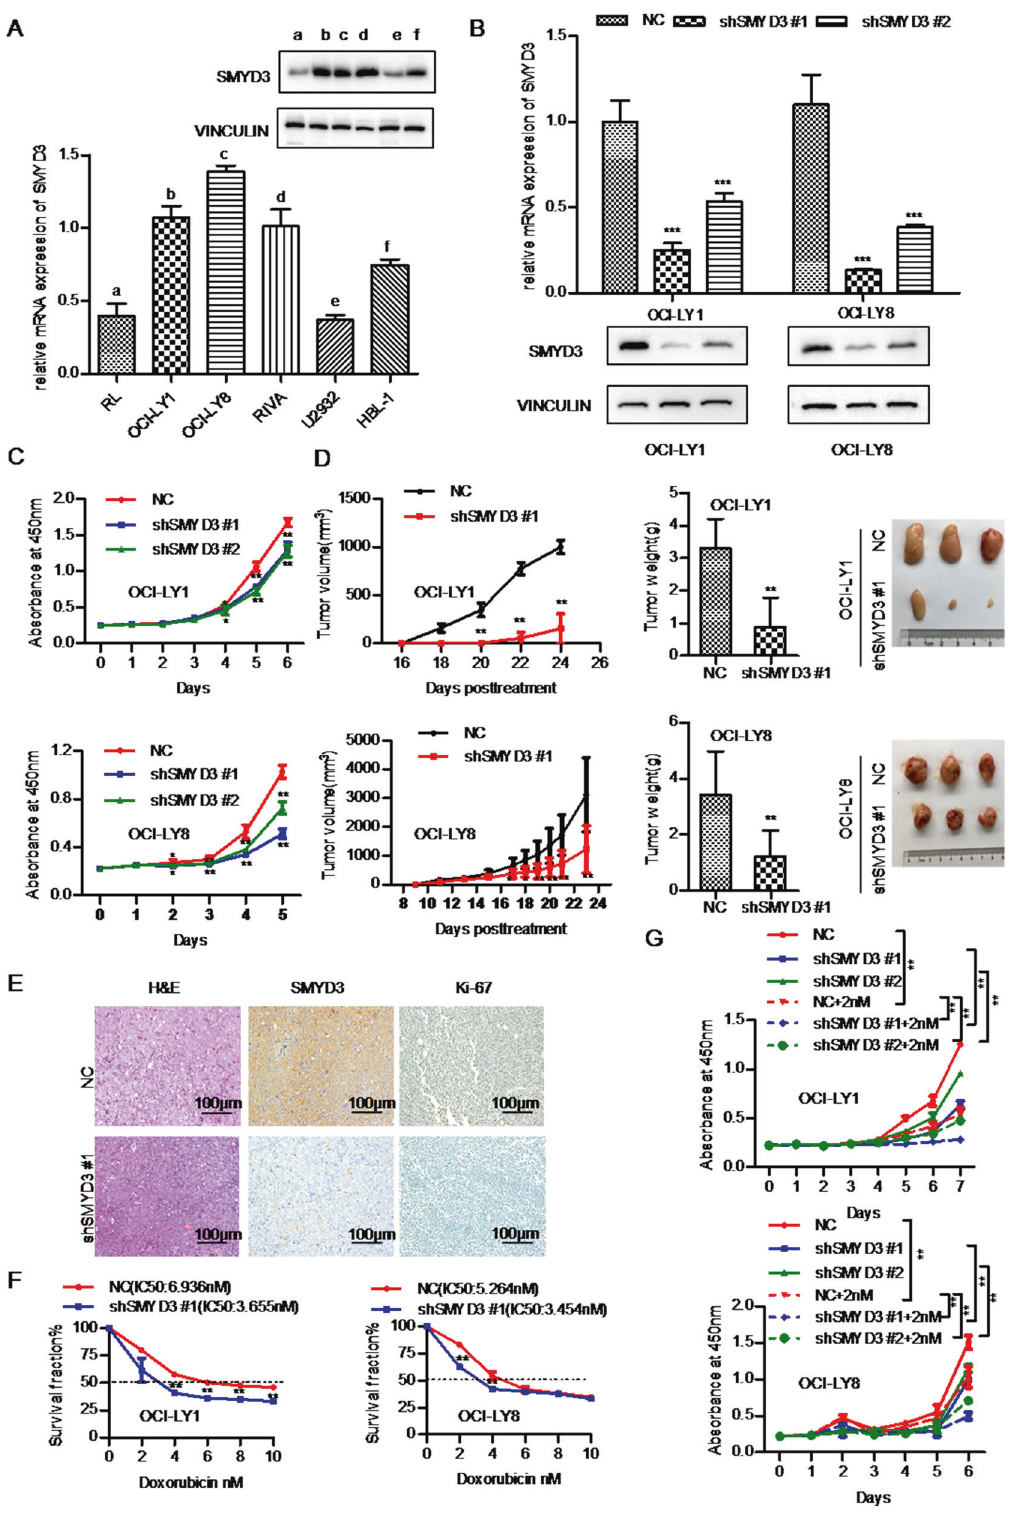
Fig. 2 Stable knockdown of SMYD3 suppresses the proliferation of DLBCL cells in vitro and in vivo and increases their sensitivity to doxorubicin in vitro. A The mRNA and protein expression levels of SMYD3 in the RL, OCI-LY1, OCI-LY8, RIVA, U2932 and HBL-1 DLBCL cell lines. B Knockdown ef fi ciency of SMYD3 mRNA and protein levels in the OCI-LY1 and OCI-LY8 cell lines. C Knockdown of SMYD3 expression suppressed DLBCL cell proliferation in the OCI-LY1 and OCI-LY8 cell lines. D Tumorigenicity assay of SMYD3-knockdown OCI-LY8 and OCI-LY1 cells. E Hematoxylin and eosin and SMYD3 and Ki67 staining of xenograft tissue samples from mice injected with SMYD3-knockdown OCI-LY8 cells. Magni fi cation, x200. Scale bar, 100 μ m. F IC 50 values for doxorubicin in OCI-LY1 and OCI-LY8 cell lines were obtained using Cell Counting Kit-8 assays. G SMYD3 knockdown cells proliferated much more slowly after treatment with doxorubicin over a period of 6 days in OCI-LY1 and OCI-LY8 cells. * P < 0.05, ** P < 0.01, *** P < 0.001. DLBCL Diffuse large B-cell lymphoma, SMYD3 SET and MYND domain containing 3. Cell Death and Disease (2022)